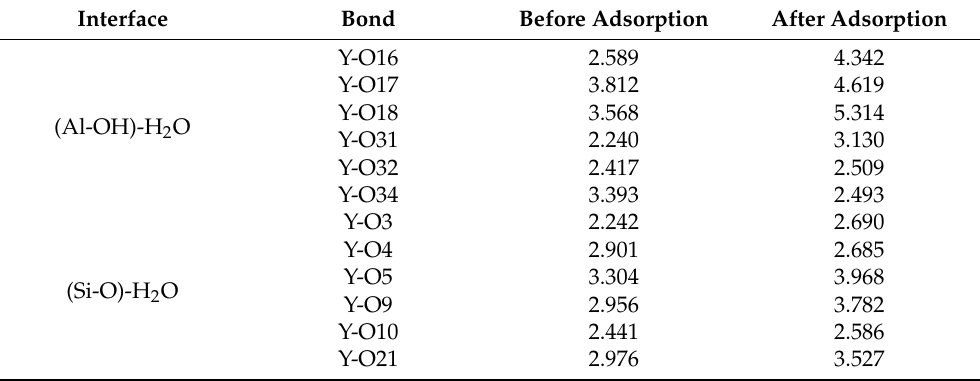
Figure 4. The serial numbers of oxygen atoms on the surface of kaolinite. (Note that the atomic number is automatically generated by the MS software system.). Table 1. Change of distance between Y(III) and O atoms on the kaolinite surface.